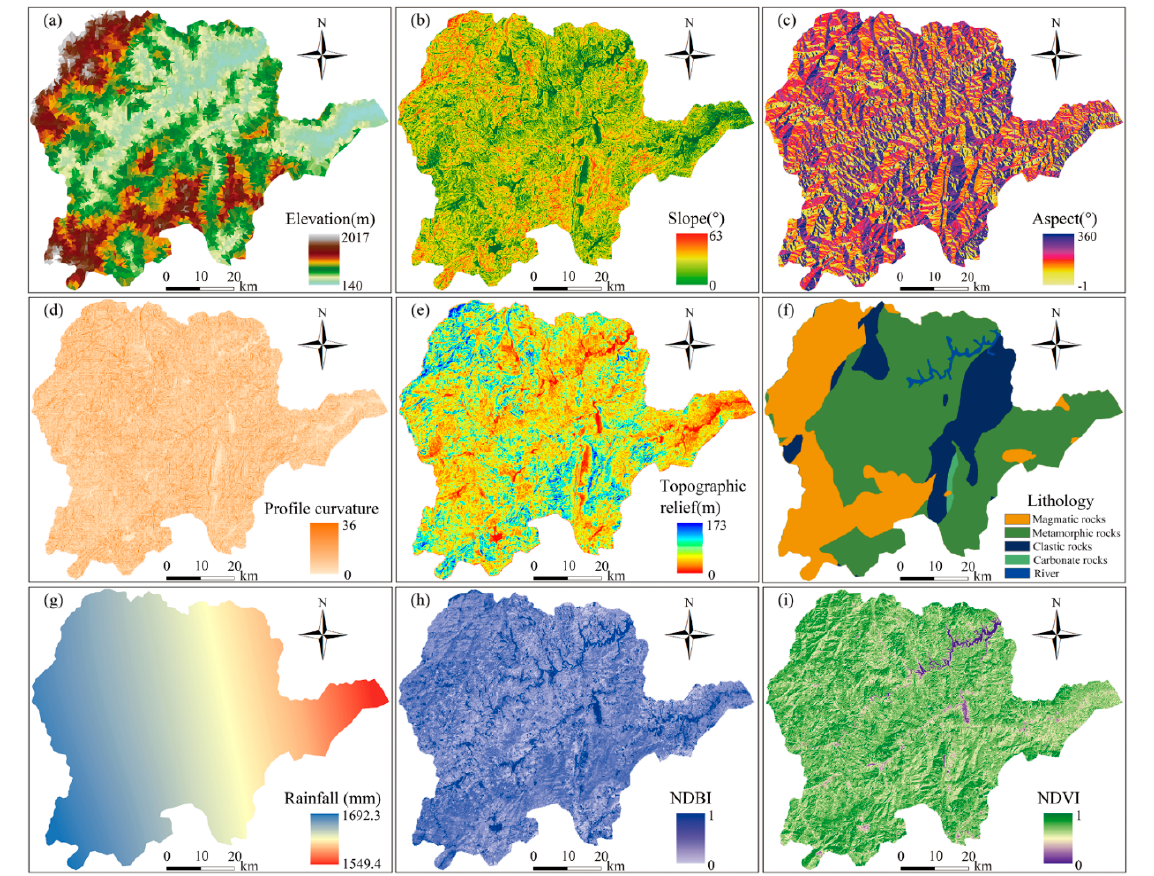
Figure 5. Environmental factors: ( a ) elevation; ( b ) slope; ( c ) aspect; ( d ) profile curvature; ( e ) topo- graphic relief; ( f ) lithology; ( g ) annual rainfall; ( h ) NDVI; ( i ) NDBI. (Road density, plane curvature and river density are not present).